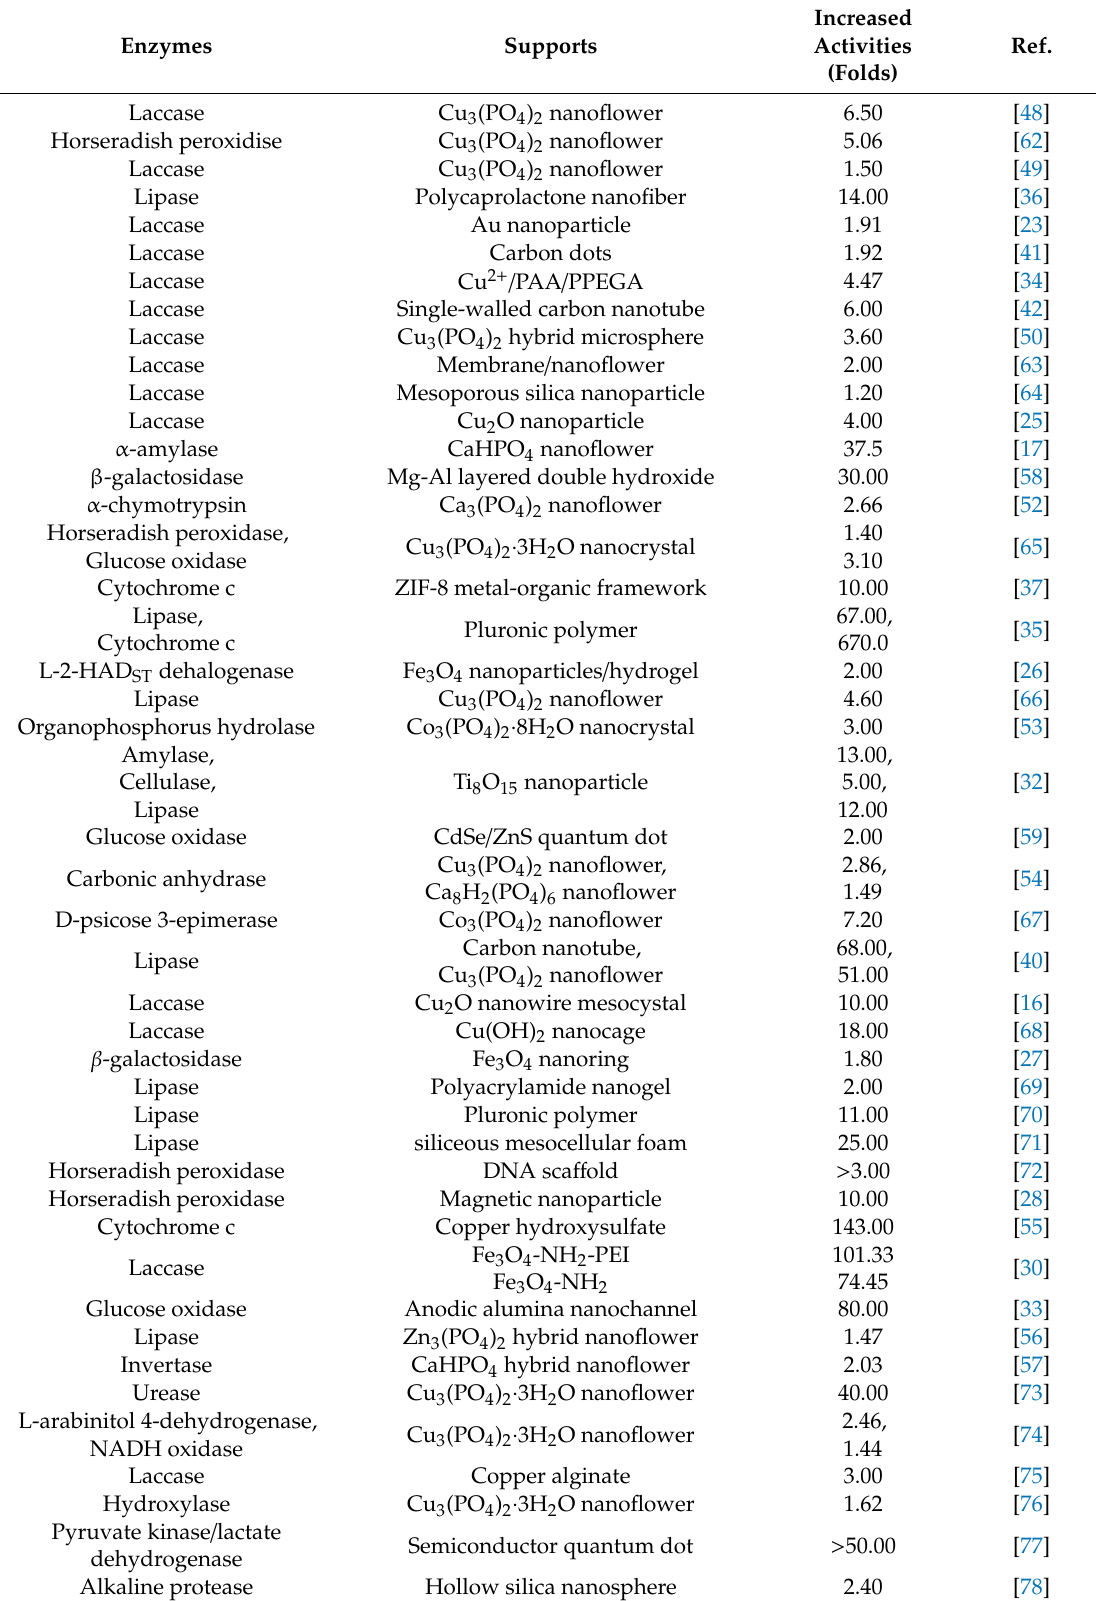
Table 1. Recent nanobiocatalysts with increased activities, constructed by various nanostructure supports and